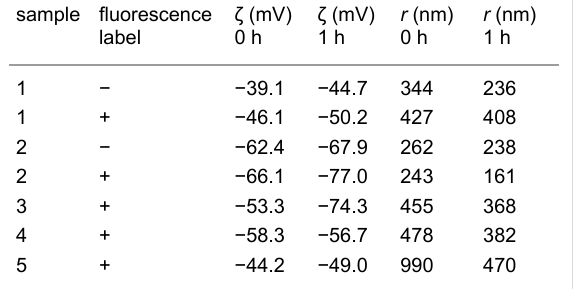
Table 2: Change in ζ -potential and hydrodynamic diameter after 1 h of action by buffer B (2000 mg/L of phosphate) on the nanoparticles. sample fluorescence